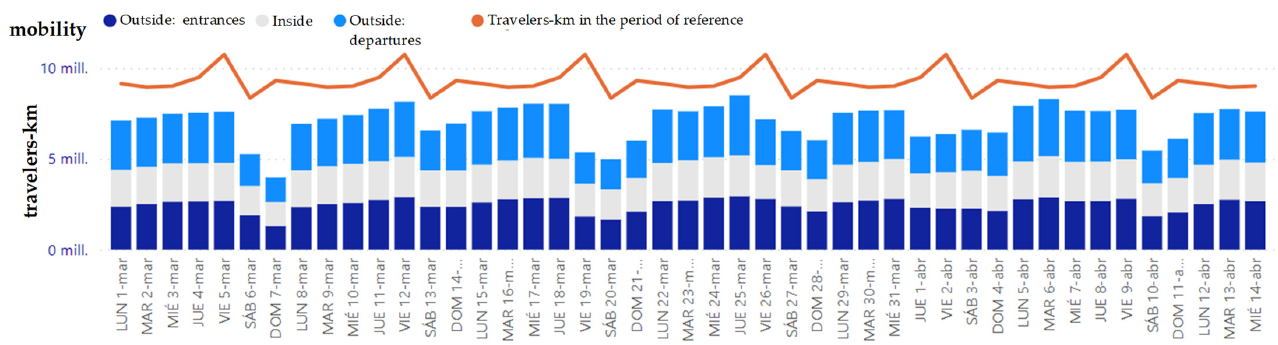
Figure 7. Evolution of daily mobility using public transport in Cartagena in March and April 2021 (in blue) compared to 2019 (in red). Data source: Ministry of Transport of Spain and Cartagena City Council.